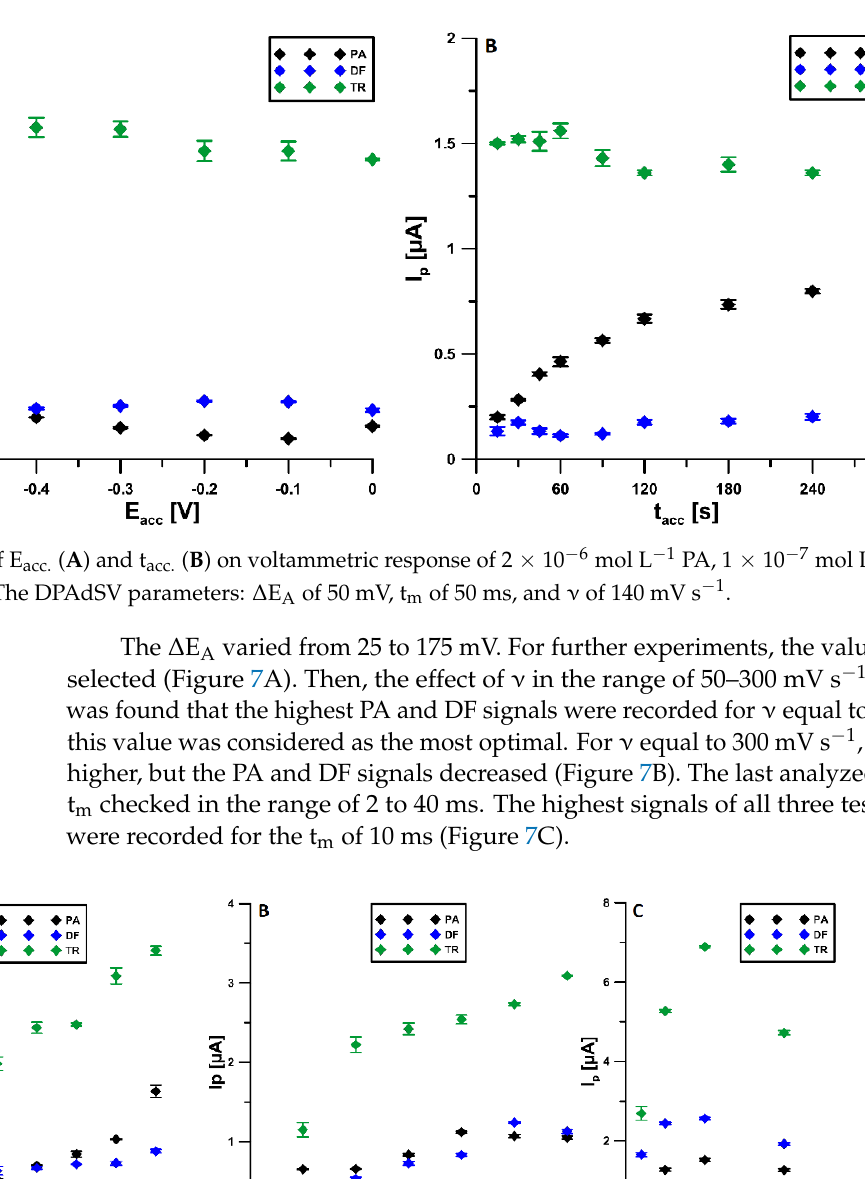
Figure 7. Influence of ΔE A ( A ), ν ( B ), and t m ( C ) on voltammetric response of 2 × 10 −6 mol L −1 PA, 1 × 10 −7 mol L −1 DF, and 1 × 10 −5 mol L −1 TR. The DPAdV parameters: E acc. of − 0.4 V and t acc. of 120 s.